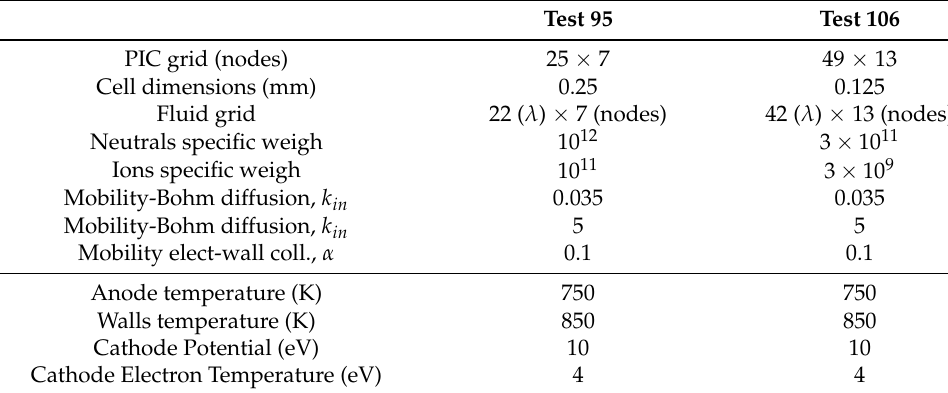
Table 2. SPT-100: characteristics of discharge simulation tests.